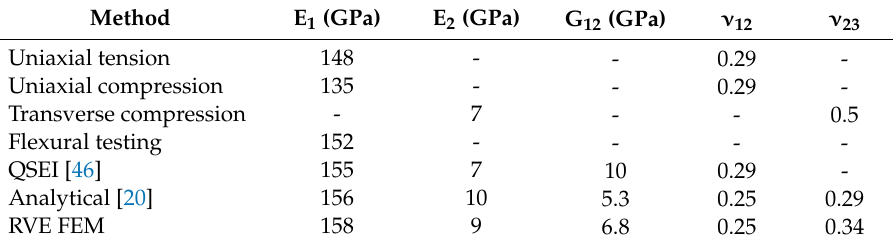
Table 4. Summary of simulated and measured composite properties.